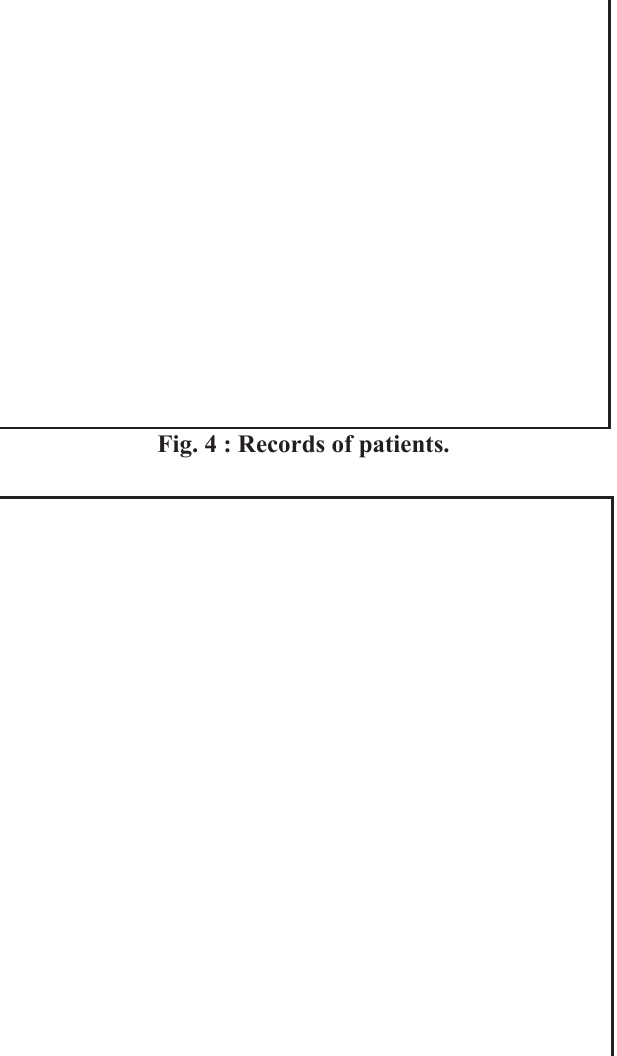
Fig. 6 : After reading X-ray sketch filled by interpreter.